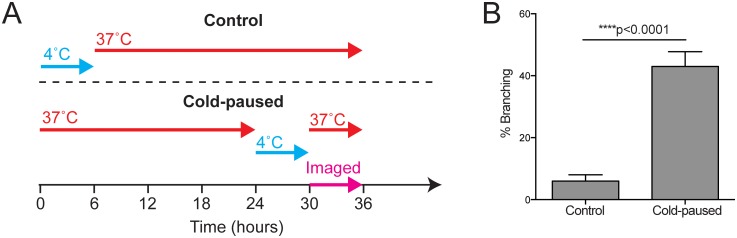
Pausing growth by temperature shifts induces apical branching.(A) Thermal inhibition of hyphal growth at 4°C followed by return to 37°C allowed the effect of pausing hyphal growth to be compared to continuously growing controls. (B) Cold-paused hyphae exhibited robust branching at hyphal tips upon return to growth conditions compared to continuously growing hyphae. N ≥ 178 hyphae per condition scored from 3 experiments. Errors bars: mean ± SEM. Statistics: Student’s T-test.